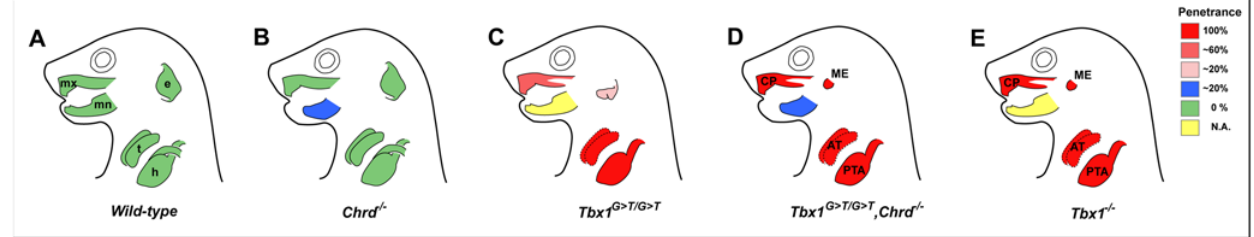
Figure 5. Developmental defects of Chrd , Tbx1 , and compound mutants. Organs that are defective in the various classes of Chrd and/or Tbx1 mutant embryos studied here. Degree of penetrance of phenotypes reminiscent of 22q11DS is shown by variable intensity of red shading, as defined to the upper right of the figure. (A) Normal morphology (indicated by green shading) of organs sensitive to loss of Chrd and/or Tbx1 and their location in wildtype embryos: mx, maxilla; mn, mandible; e, ear; t, thymus; h, heart; CP, cleft palate; ME, malformed ear; AT, athymia; PTA, persistent truncus arteriosus. (B) Chrd null mice display a markedly truncated mandible phenotype at low penetrance (blue shading), while other structures are unaffected. (C) Tbx1 G . T/G . T embryos sometimes develop mild craniofacial defects (note partially dysmorphic ear) compared to Tbx1 2 / 2 null embryos, while AT and PTA are fully penetrant. We did not quantitatively score for the presence of previously reported possible subtle mandibular dysmorphology associated with loss of Tbx1 (yellow, NA: not addressed, [3]), quite distinct from the Chrd truncation phenotype. (D) In the Chrd 2 / 2 ; Tbx1 G . T/G . T double mutant embryos, all indicated organs develop abnormally with complete penetrance, with an overall phenotype identical with (E) Tbx1 2 / 2 null embryos. Rarely, these defects are superimposed on mandibular truncations (blue), as seen at similarly low penetrance in Chrd 2 / 2 mutants.